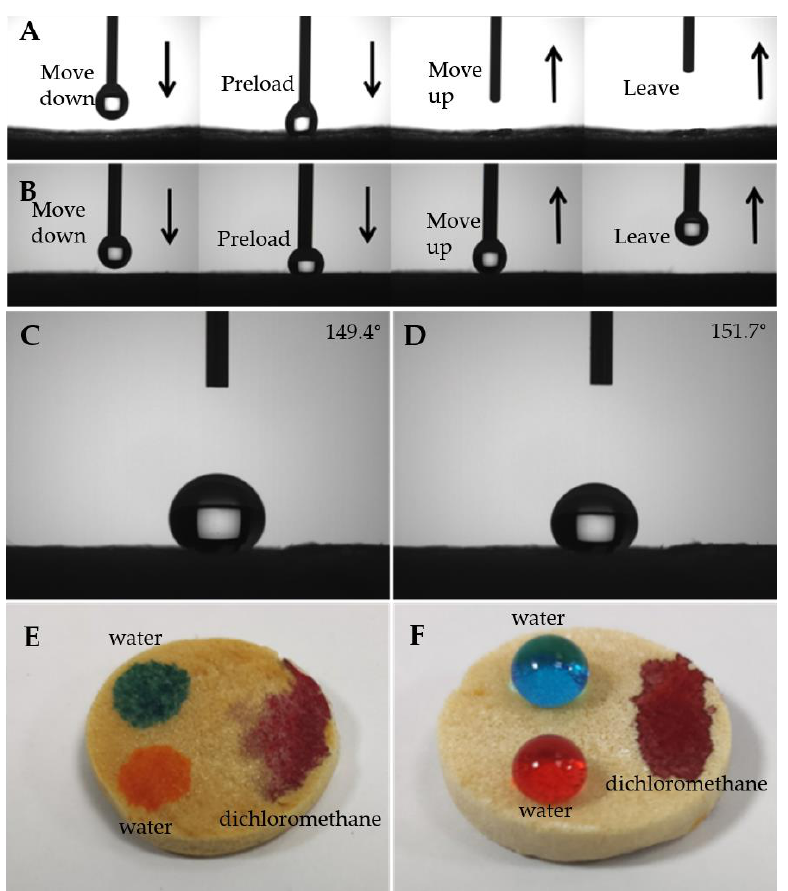
Figure 5. Dynamic water droplet adhesion and repelling test of CS ( A ) and F-CS ( B ), water contact angles of F-CS aerogel treated by different pH conditions ( C : pH = 2 and D : pH = 12), and digital pictures of water (dyed with methyl blue and methyl orange) and dichloromethane (dyed with Oil red O) droplets on the surface of CS ( E ) and F-CS ( F ) aerogels.